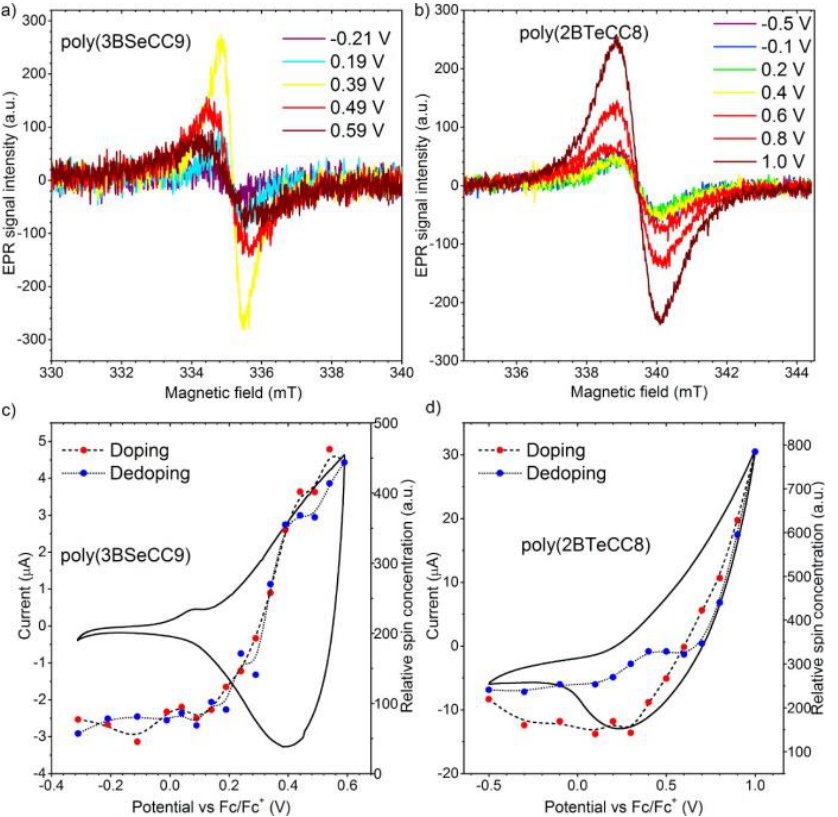
Figure 10. Selected EPR spectra measured during doping of a thin film of ( a ) poly(3BSeCC9) and ( b ) poly(2BTeCC8). Relative spin concentration during doping (red circles) and dedoping (blue circles) of a thin film of ( c ) poly(3BSeCC9) and ( d ) poly(2BTeCC8). Recorded in 0.1 M Bu 4 NBF 4 /DCM supporting electrolyte solution. Potentials recorded relative to ferrocene/ferrocenium (Fc/Fc + ) redox couple. Reprinted with permission from [56]. Copyright 2017 American Chemical Society.